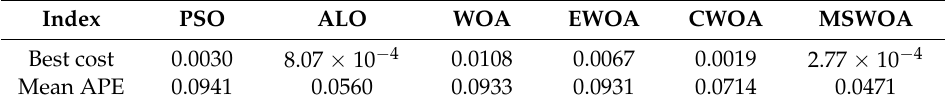
Table 13. Mean best cost and APE under load condition.